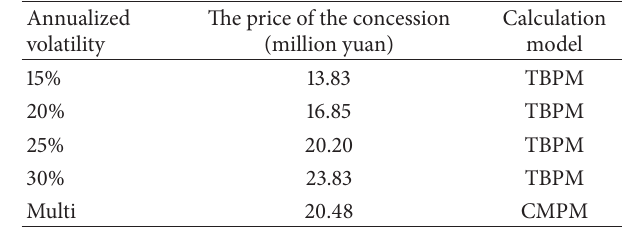
Table 6: The annual net cash flow after purchasing the mining concession.